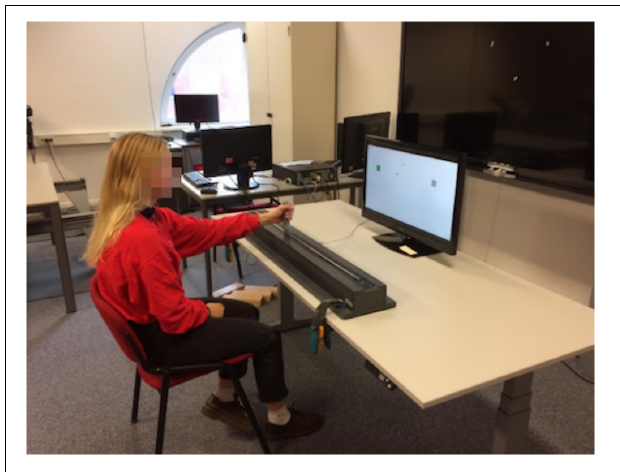
FIGURE 1 | Illustration of the research